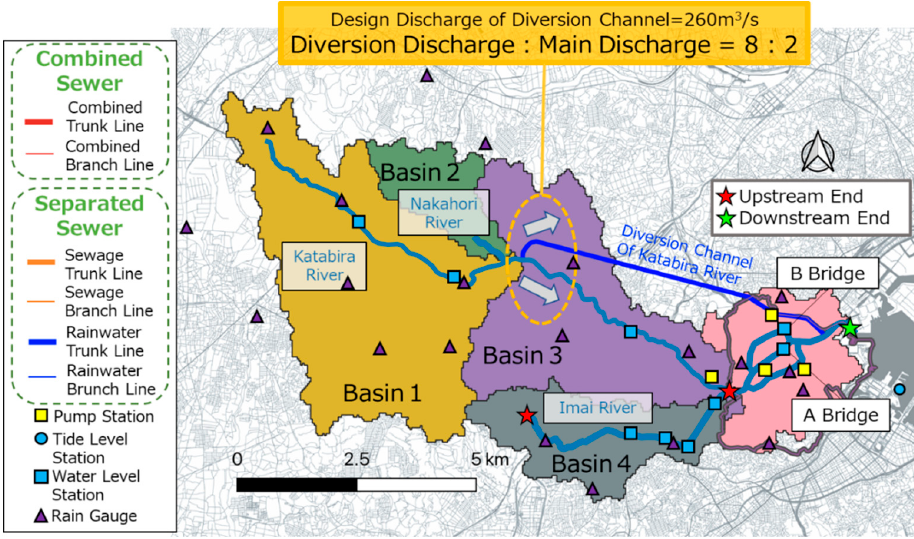
Figure 8. Catchment division diagram.